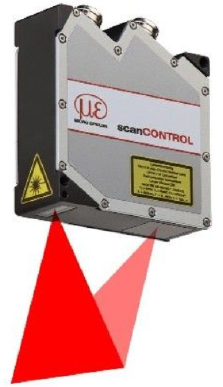
Figure 3. scanCONTROL profile scaner.